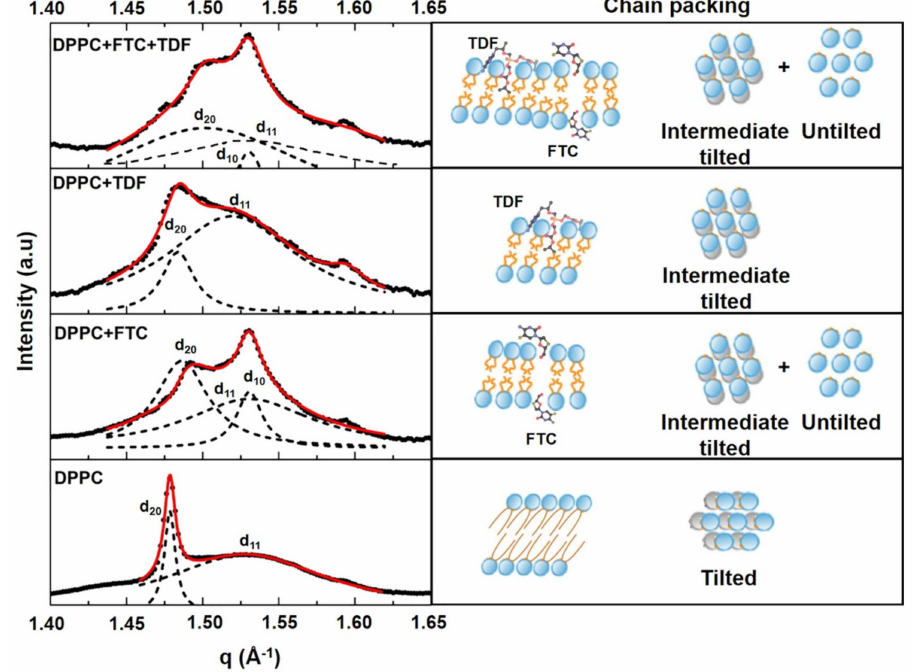
Figure 3. Wide angle X-ray di ff raction (WAXS) patterns of DPPC or DPPC containing TDF, FTC, or TDF and FTC (3:2 w / w ) measured in the L β (cid:48) phase of DPPC. Solid red lines give the best fit of the Lorentzian’s analysis model (dashed lines) to the scattered intensities. A model of drug–membrane interaction is proposed for each di ff ractogram together with the resultant chain